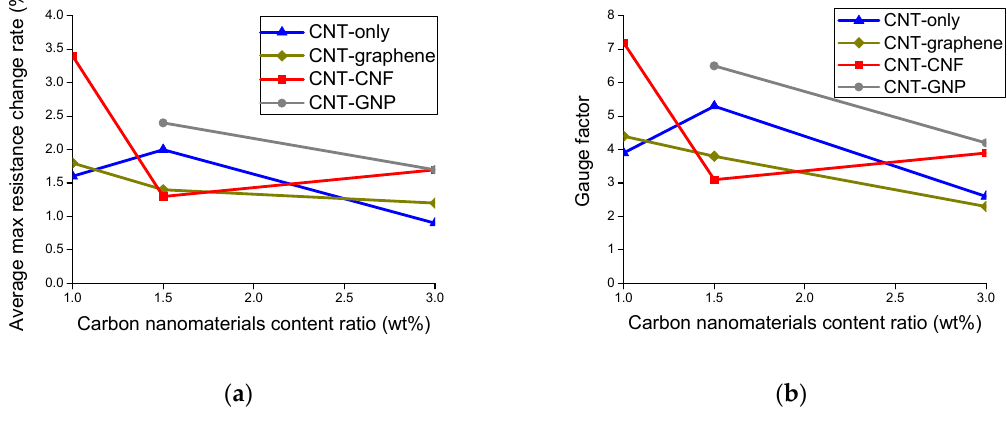
Figure 8. ( a ) Maximum resistance change rate, and ( b ) gauge factor of the epoxy-based composites incorporating CNT-only, CNT–graphene, CNT–CNF, or CNT–GNP, determined as a function of CNM content ratio and derived from the piezoresistive sensing test.